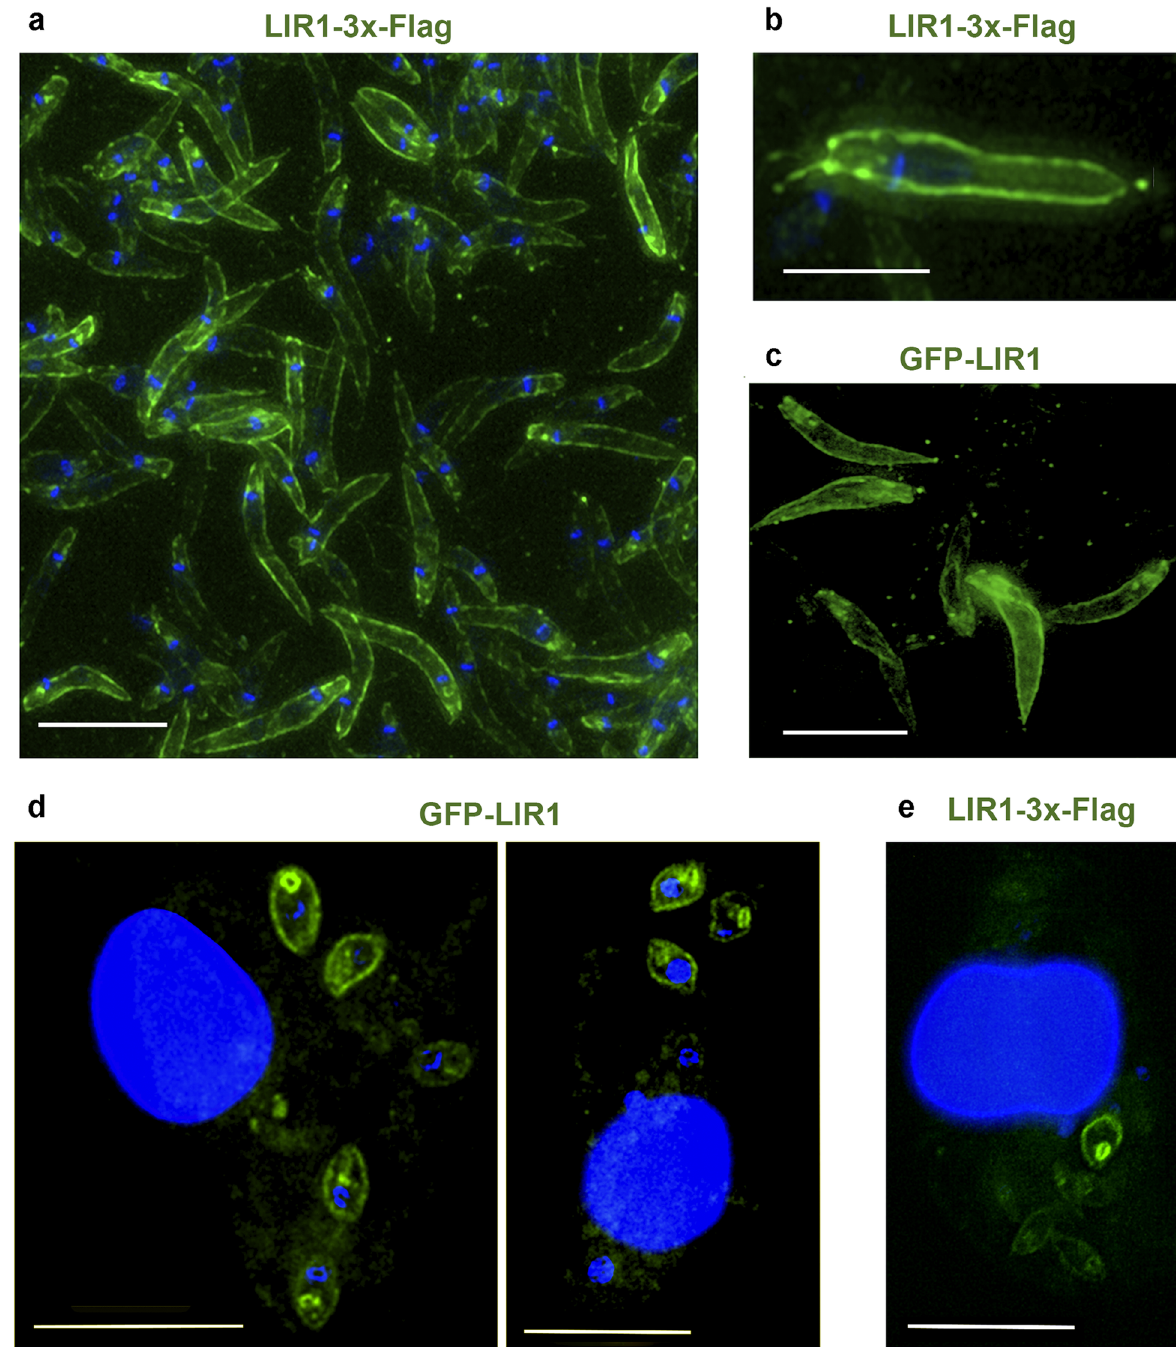
Fig 2. LIR1 localizes at the plasma membrane of promastigotes and intracellular amastigotes. (a,b) Immunofluorescence deconvolution images of L . amazonensis promastigotes expressing LIR1 with a 3xFlag at the C-terminus. Blue, DAPI DNA staining. Green, anti-3xFlag antibodies. Scale bars: 7 μm (a) and 3.5 μm (b). (c) Deconvolution fluorescence microscopy image of L . amazonensis promastigotes expressing LIR1 fused to GFP at the N-terminus. Scale bar: 11 μm. (d,e) Immunofluorescence deconvolution images of BMM infected for 48 h with axenic amastigotes expressing LIR1 fused to GFP at the N-terminus (d) or 3xFlag at the C-terminus (e). Blue, DAPI DNA staining. Green, GFP-LIR1 or anti-3xFlag antibodies. Scale bars: 11 μm.